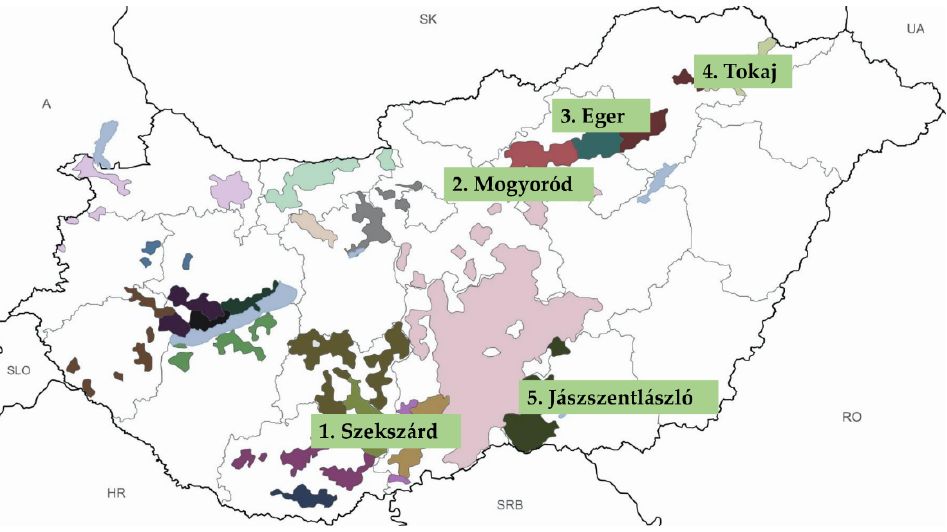
Figure 1 . Location of sample collection sites in different vine growing regions of Hungary. Figure 1. Location of sample collection sites in different vine growing regions of